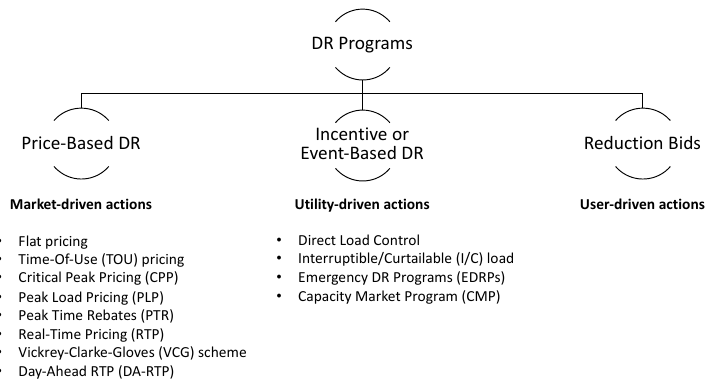
Figure 3. Classification of Demand Response (DR) schemes according to the party that initiates the demand reduction action. Adopted from [13,14].